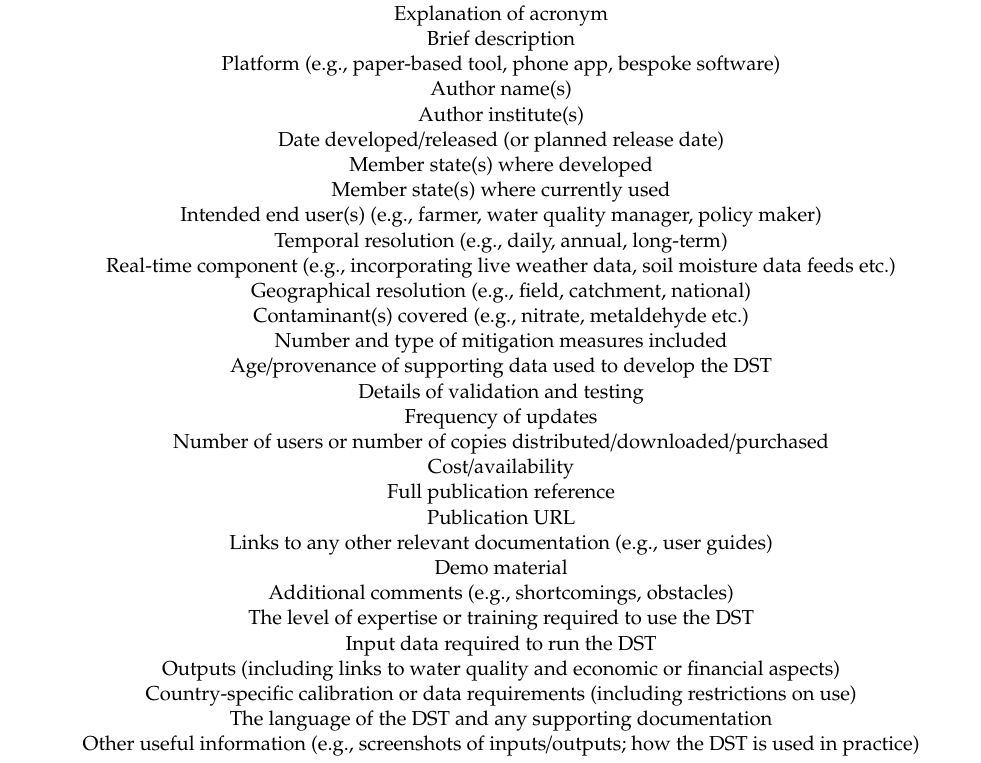
Table A2. Details for each DST supplied by FAIRWAY project